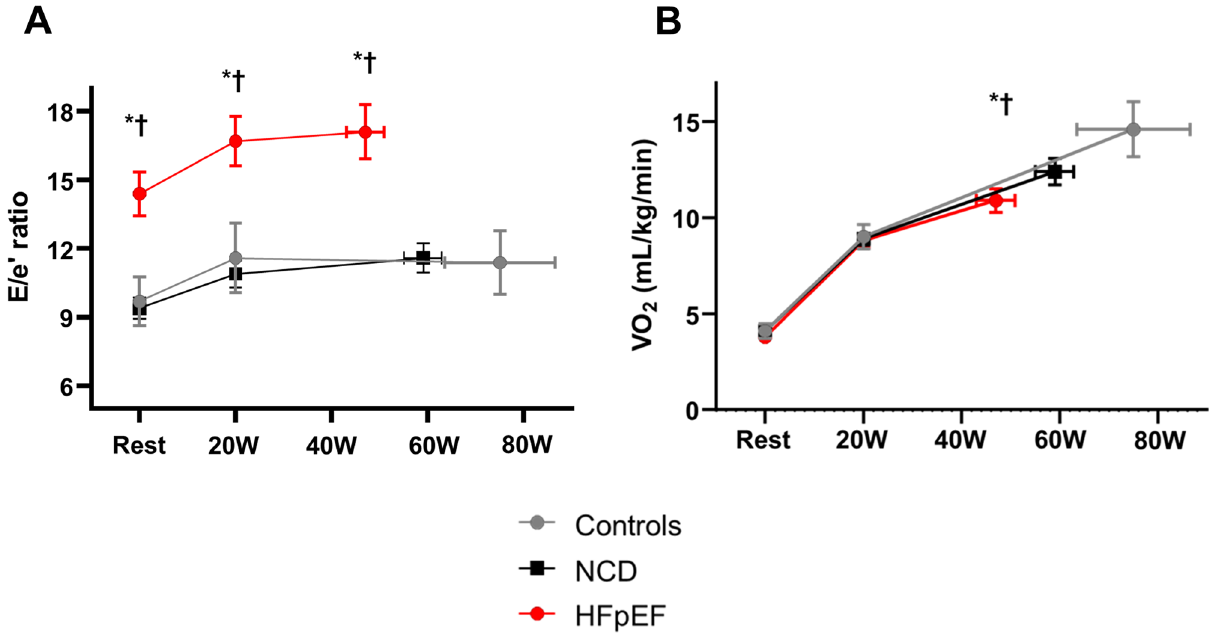
Figure 1. ( A , B ) Changes in the early transmitral flow velocity/early diastolic mitral annular velocity ratio and peak oxygen consumption at rest and during low-level (20 W) and peak exercise in patients with HFpEF and NCD and the controls. *P < 0.05 vs. Controls; † P < 0.05 vs. NCD. HFpEF, heart failure with preserved ejection fraction; NCD, noncardiac